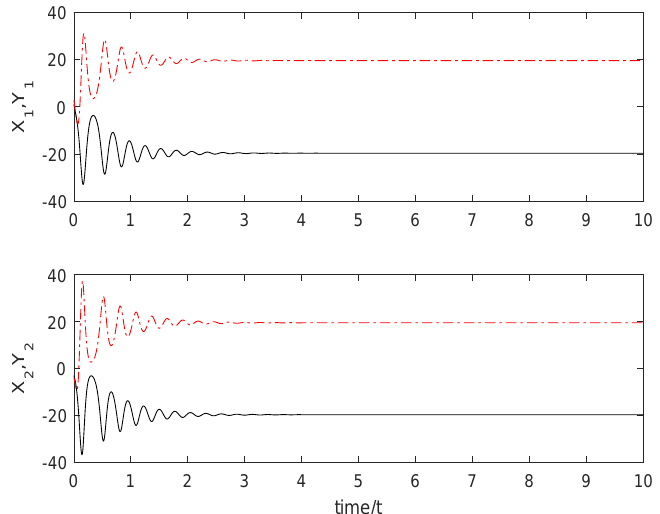
Figure 5. The states of the master subsystem (44) and the slave subsystem